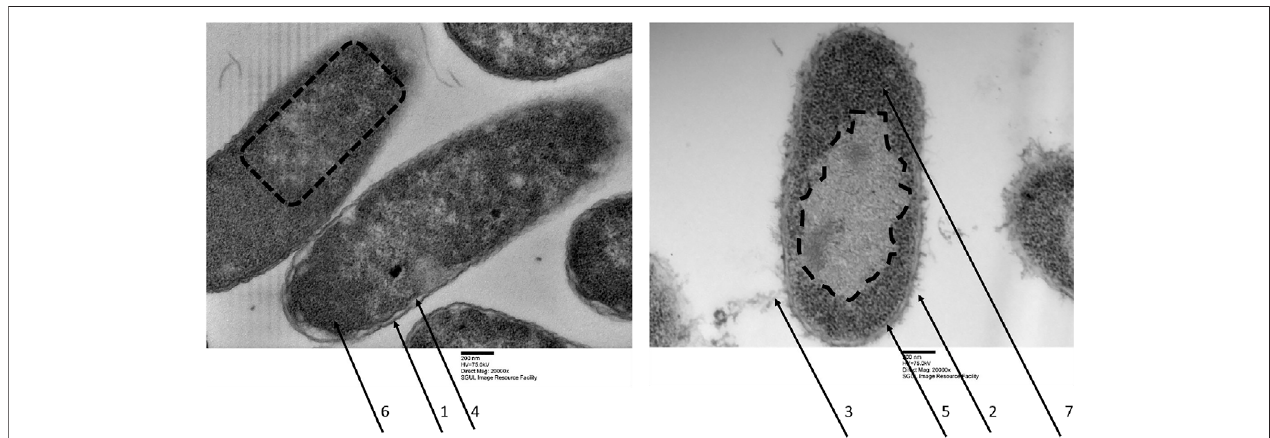
FIGURE 1 | Transmission electron micrographs of Escherichia coli , left untreated samples, right treated with optP7 for 60 min, 20,000 times magni fi cation. The dotted lines indicate the nucleoid, arrows one and two show the outer membrane, three shows blebbing of the outer membrane and release of LPS, four and fi ve show intact inner membrane, six and seven show granular structures in the